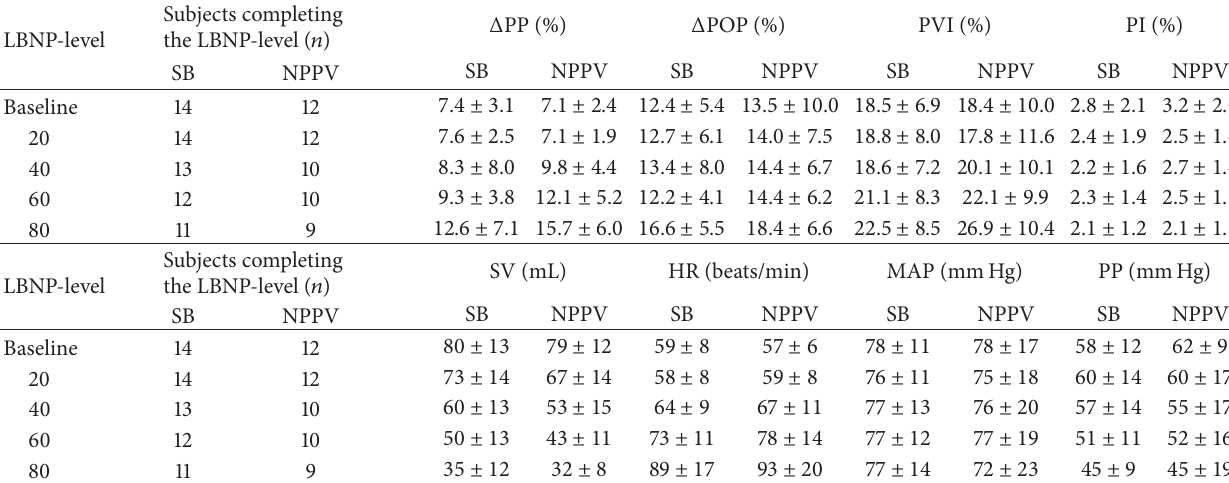
Data are mean ± SD. LBNP: lower body negative pressure; SB: spontaneous breathing; NPPV: noninvasive positive pressure ventilation; Δ PP: pulse pressure variation; Δ POP: photoplethysmographic waveform variation; PVI: pleth variability index; PI: perfusion index; HR: heart rate; SV: stroke volume; MAP: mean arterial pressure; PP: pulse